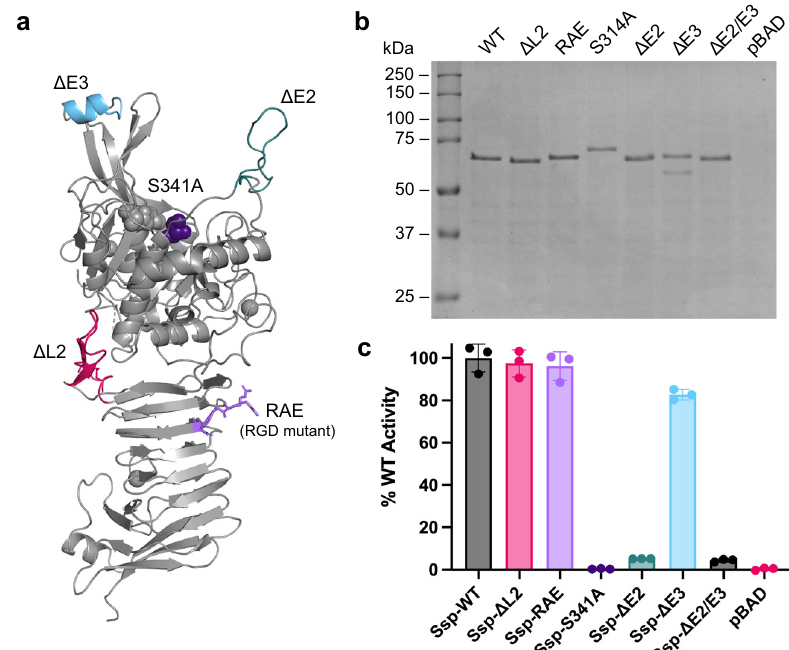
Fig.3|ExpressionandproteaseactivityofSspvariants.a CrystalstructureofSsp in cartoonrepresentationdisplaying locationofmutations. b SDS-PAGEanalysisof culture supernatant from expression of Ssp variants in E. coli Top10. Data is representative of three independent experiments. c Protease activity of Ssp var- iants using a fl uorescent casein substrate. Error bars represent standard deviation.